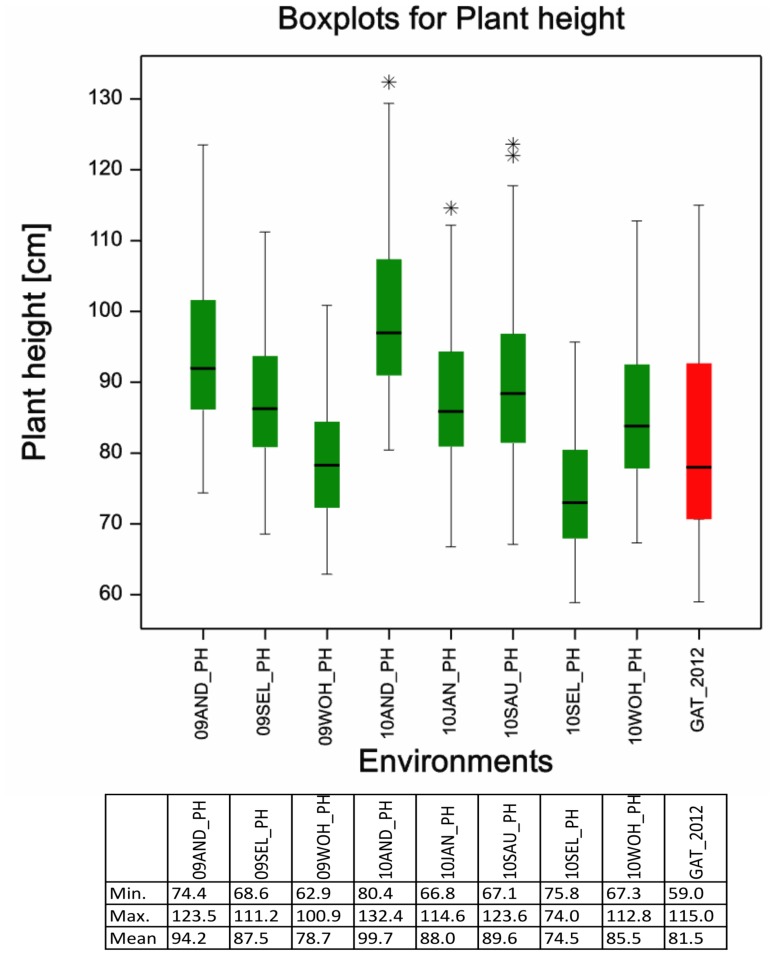
Boxplots for plant height.Boxplots for eight field environments are depicted in green, the untreated control in a nursery is shown in red. Asterisks mark outlier varieties.